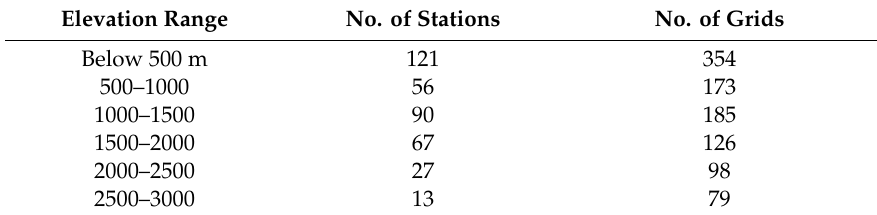
Figure 5. Mean precipitation averaged over the summer monsoon season (mm / day) for the study period, ( a ) in gauge observed and four SBP datasets at station locations, ( b ) in IMERG and GSMaP product at each grid box averaged over di ff erent elevation ranges, respectively. Table 4. Numbers of stations and grid boxes in di ff erent elevation ranges.